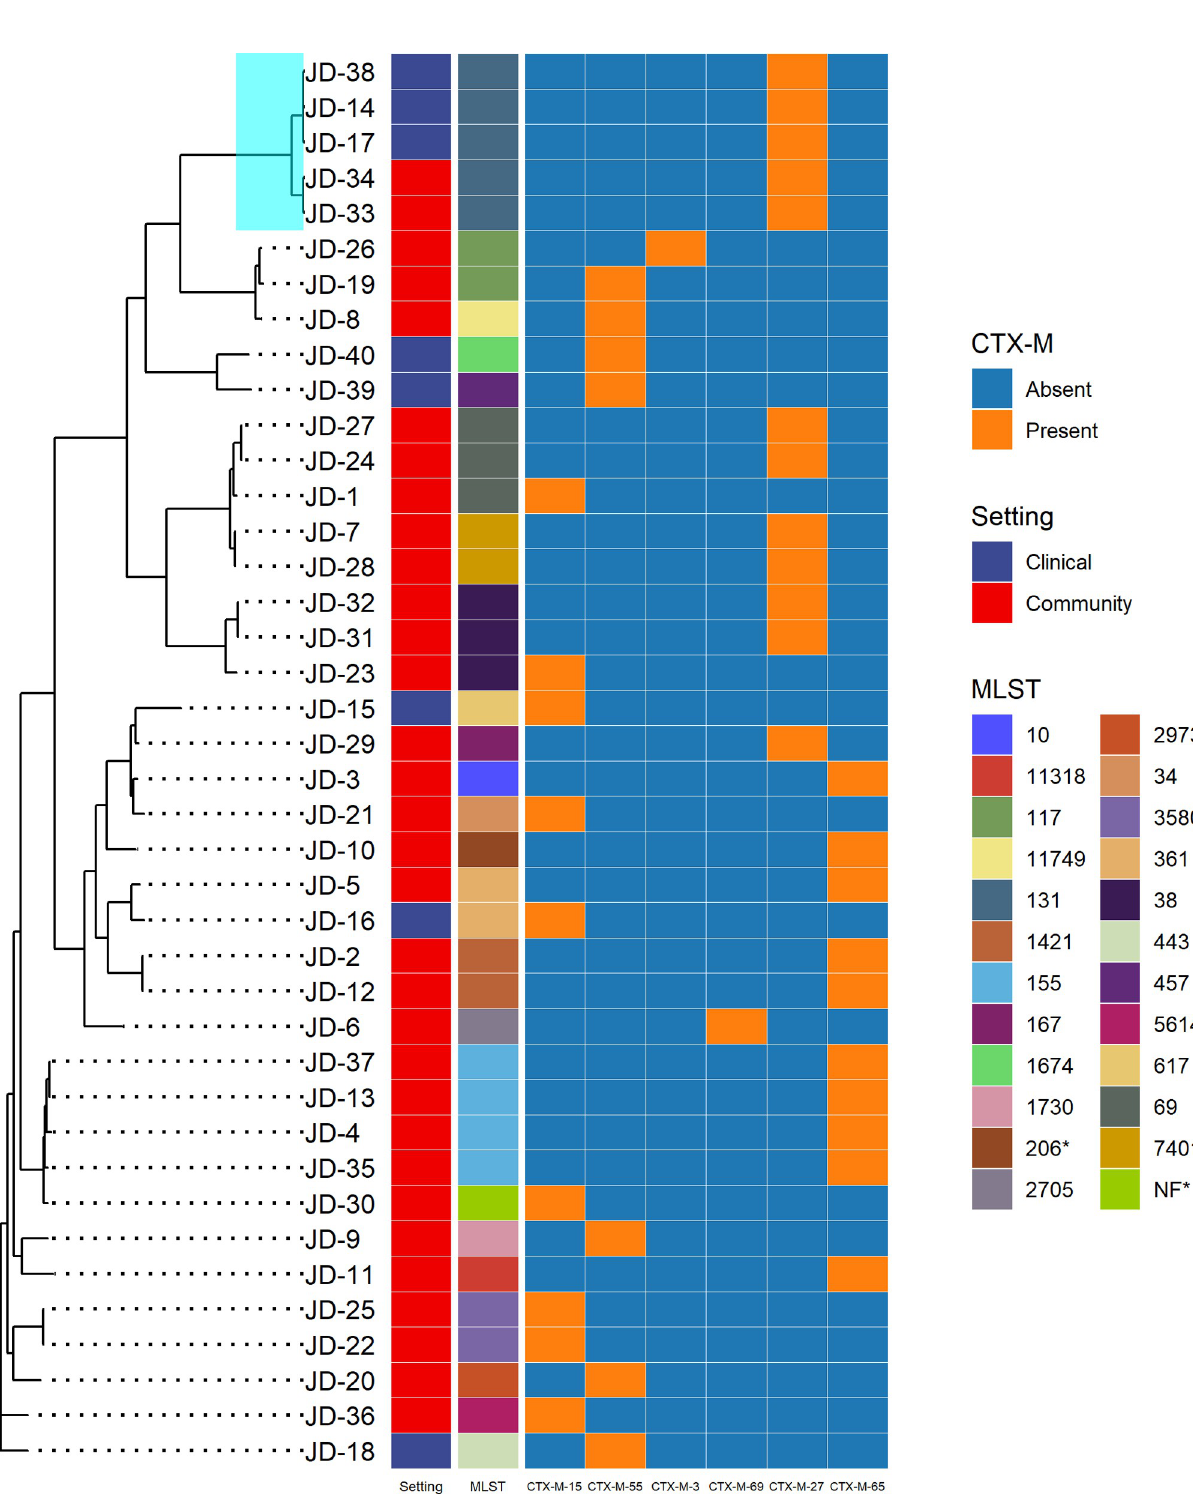
PLOS ONE | https://doi.org/10.1371/journal.pone.0265142 March 10,